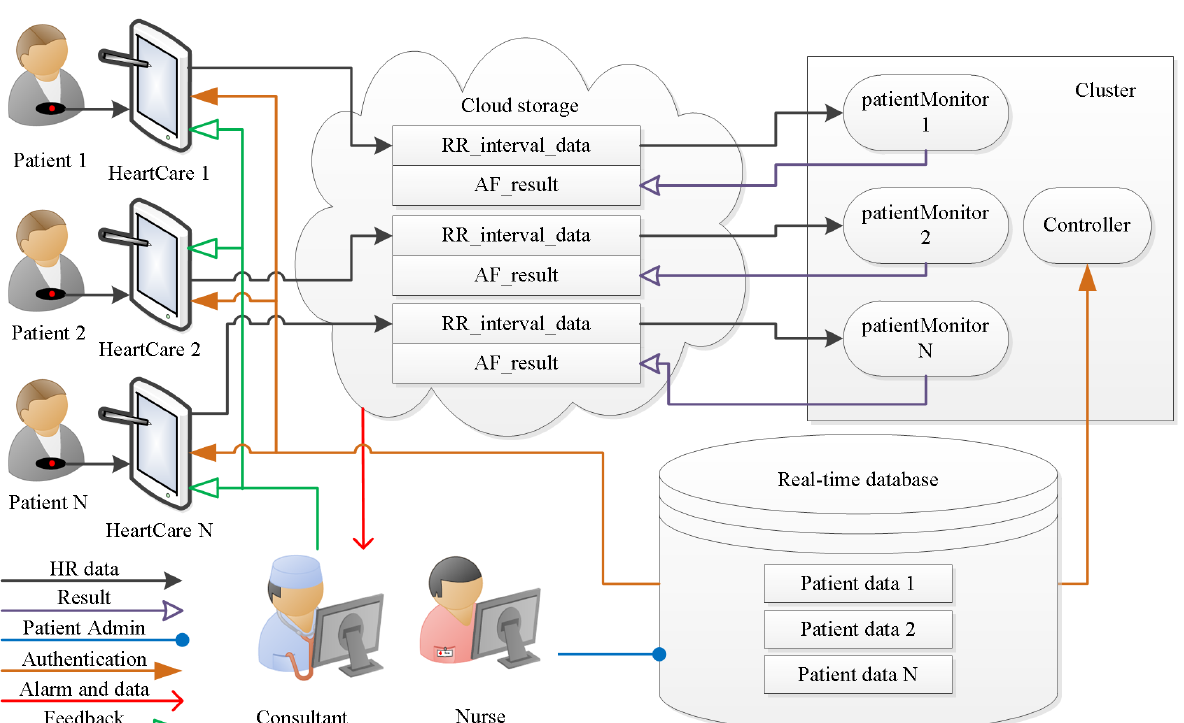
Figure 2. Architecture of the AF detection system for hybrid decision support.